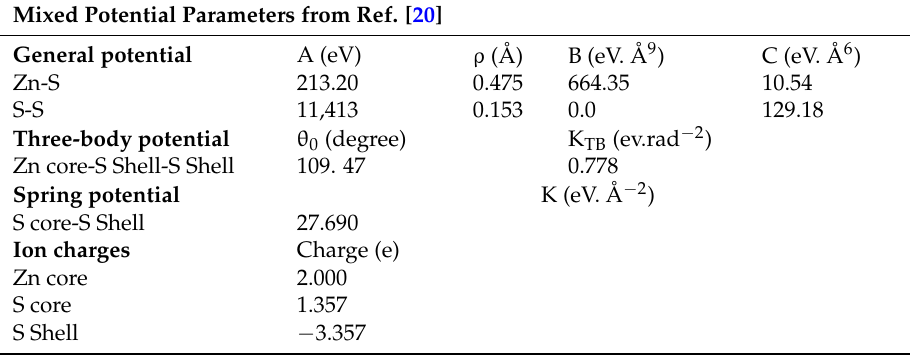
Table 1. Mixed type theoretical interatomic potential used in this work. Parameters of the applied potential were taken from its original reference